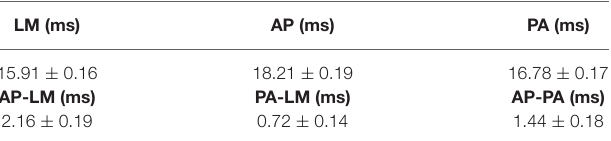
TABLE 2 | Mean ± SE for latencies and latency differences of the latero-media (LM), anterior-posterior (AP) and posterior-anterior (PA) orientations, obtained at rest pre-tDCS